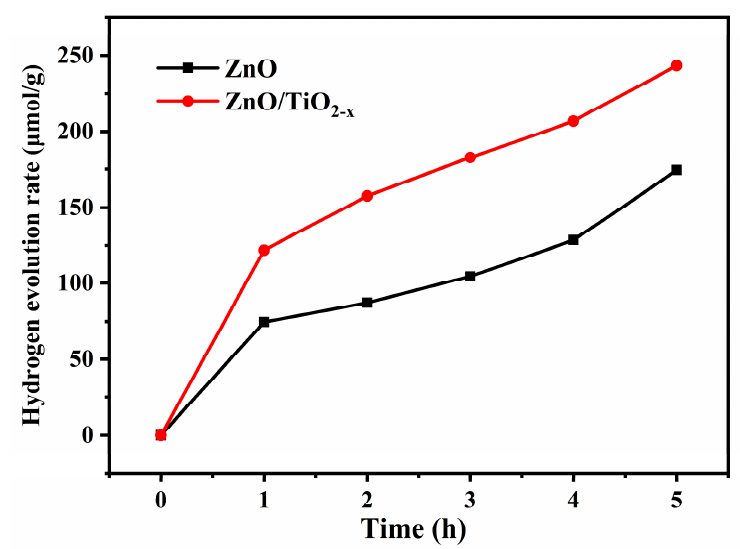
Figure 8. Temporal H 2 evolution of the pure ZnO and ZnO / TiO 2-X under AM 1.5.